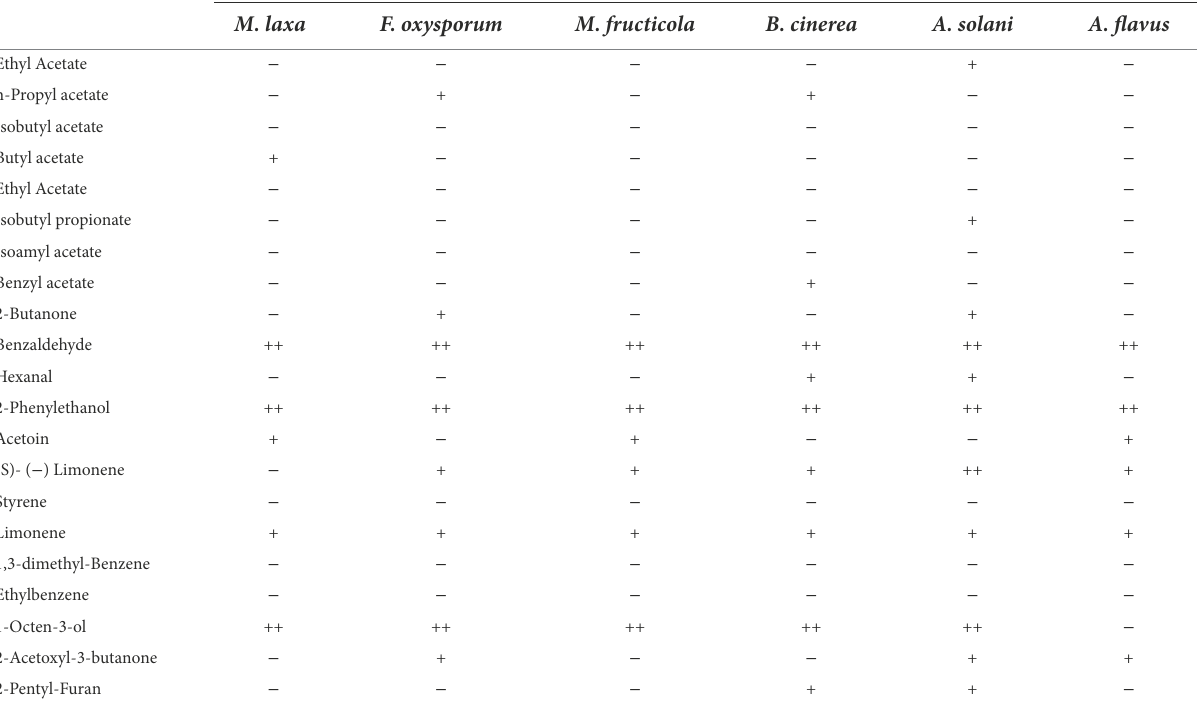
TABLE 4 Antifungal activity of VOCs by C. fimbriata . Compounds